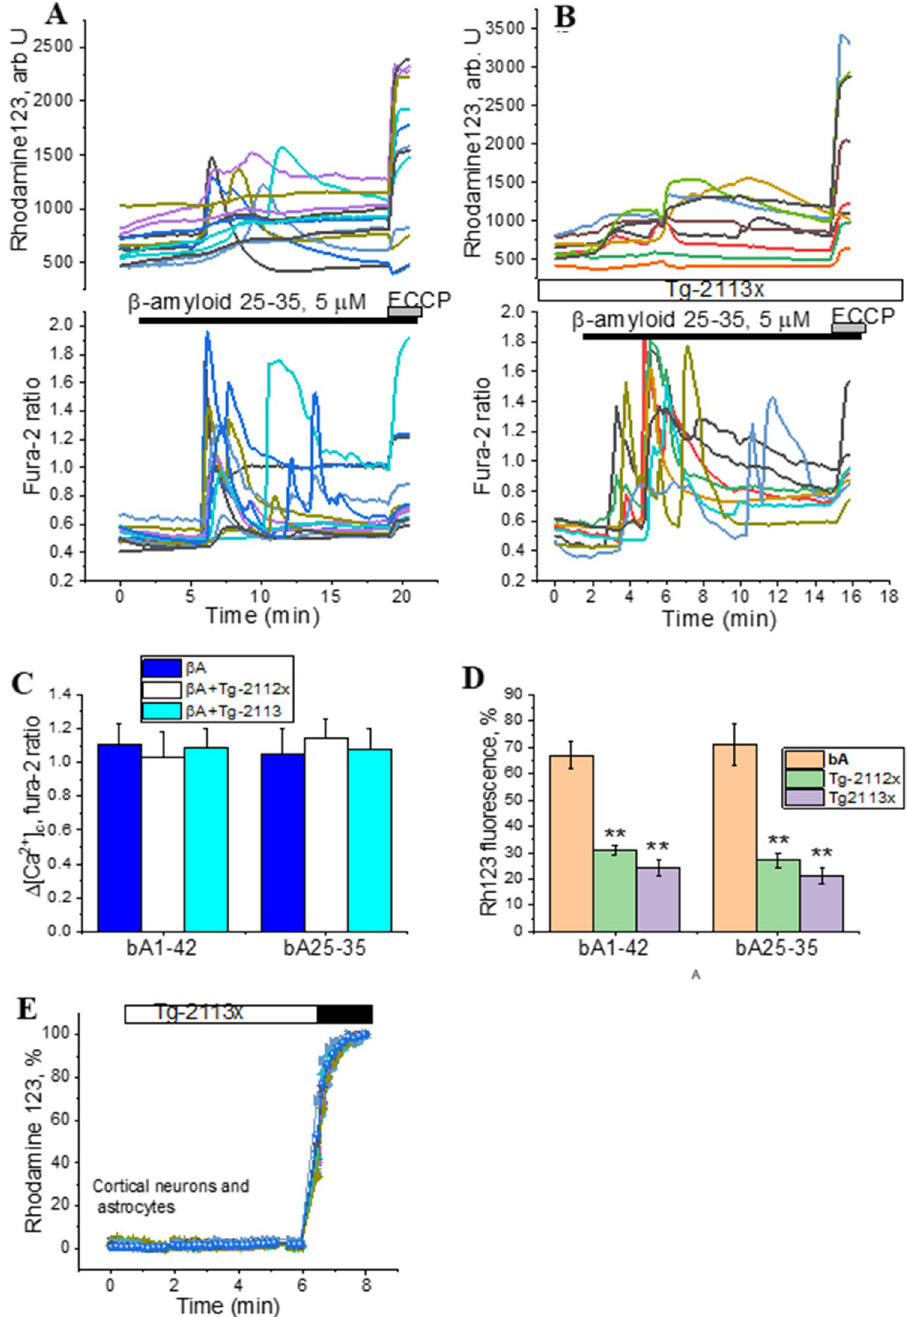
Figure 3. Effects of Tg2113x and Tg2112x on β-amyloid-induced calcium signal and mitochondrial depolarization in astrocytes from primary cortical co-cultures. Simultaneous measurement of β-A 25–35 (5 μM)-induced changes in [Ca 2+ ] c (fura-2 ratio) and mitochondrial membrane potential (Rhodamine123) in cortical astrocytes from the co-culture with neurons without Tg2113x ( A ) or after incubation with Tg2113x ( B ). Effects of Tg2112x and Tg2113x on the amplitude of βA 25–35-induced calcium signal in astrocytes (fura-2 ratio) ( C ) or mitochondrial membrane potential (% of Rhodamine123 fluorescence) ( D ). E- Tg2113x has no effect of Δψm (Rhodamine123) primary neurons and astrocytes. 1 μM FCCP was added in the end of experiments for calibration of signal. *p < 0.05; **<